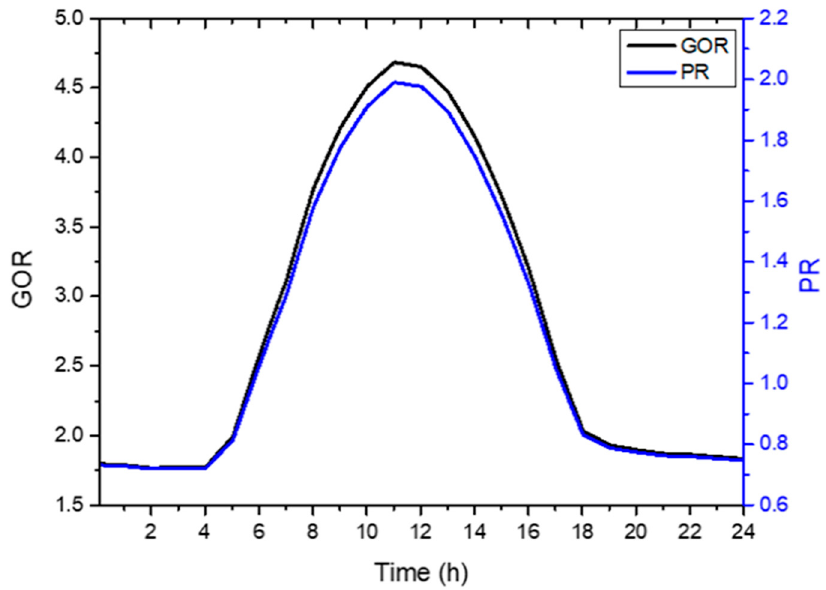
Figure 15. Variation of GOR and PR with time.